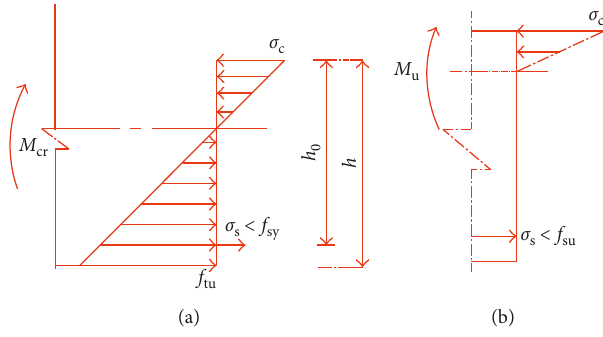
Figure 51: Cross-sectional stress profile of the stone slab with NSM CFRP: (a) elastic phase before cracking and (b) failure phase after